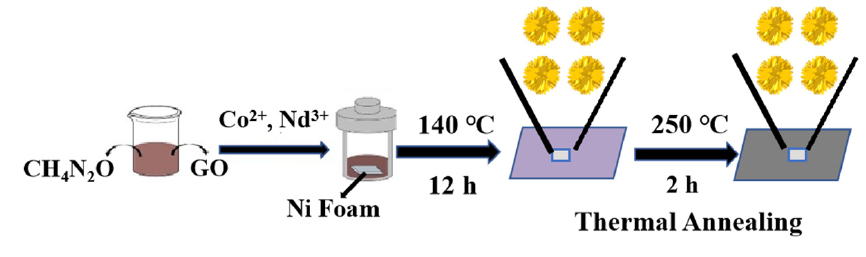
Figure 1. The preparation process of Nd 2 O 3 /Co 3 O 4 /rGO/NF composite electrode.